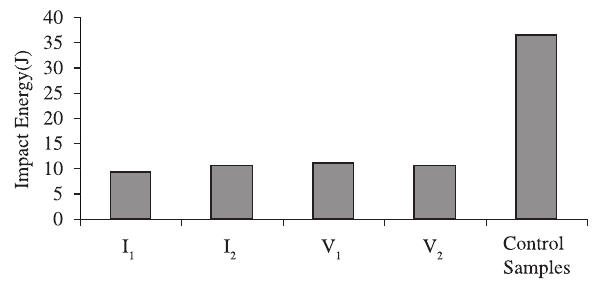
Figure 2. Average values of the impact energy of the samples at the various welding conditions in J.